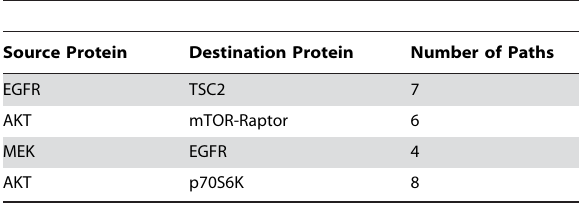
Table 4. Number of Paths Connecting Several Pairs of Compounds in the EGFR Model Used in Our Simulations